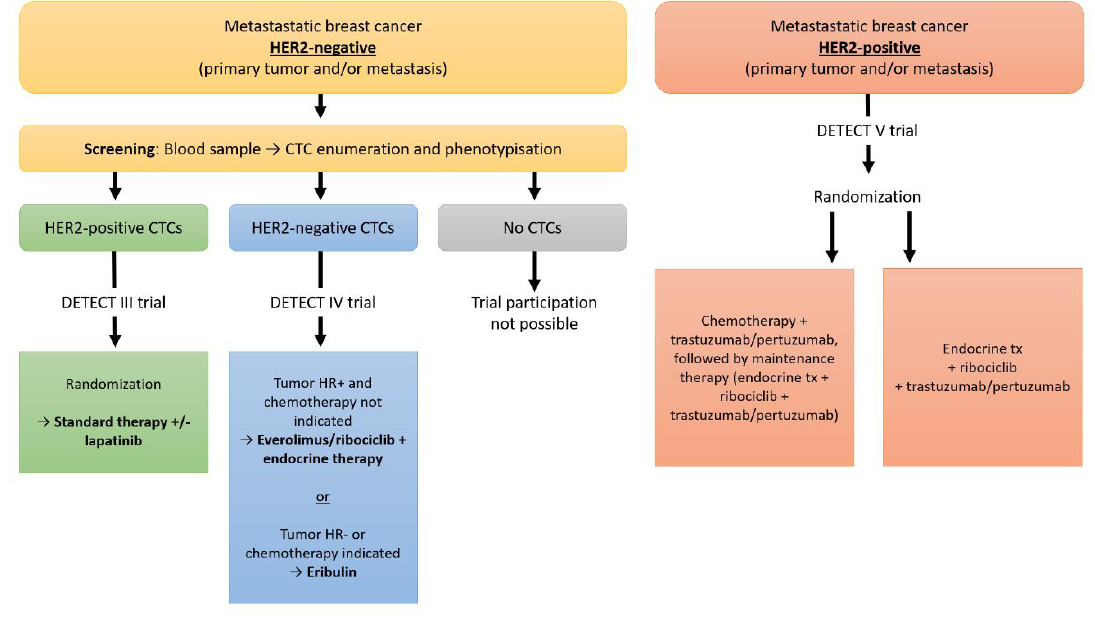
Figure 1. Design of the DETECT trials. Table 2. Clinical relevance of CTCs in metastatic breast cancer Breast Cancer Stage